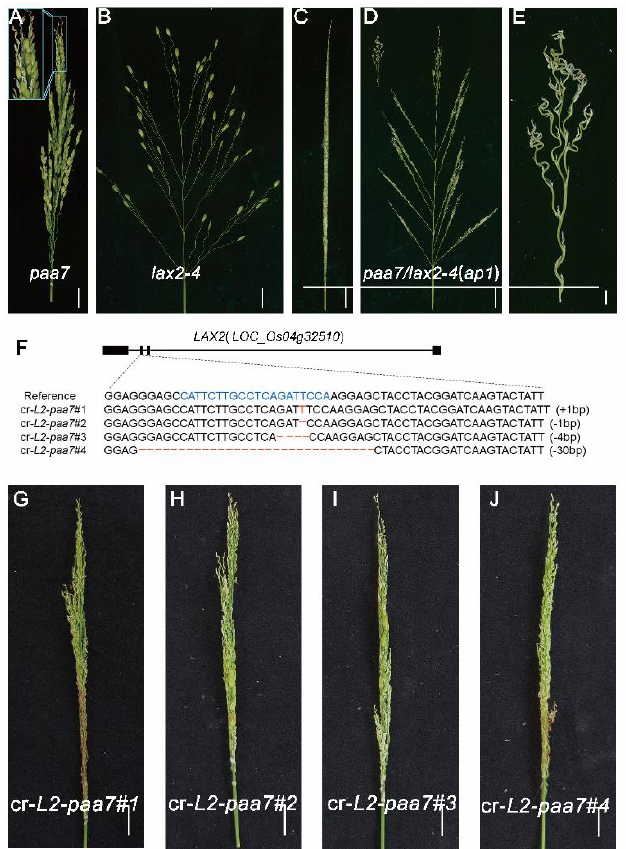
Figure 6. Phenotypic characterization of paa7/lax2 − 4 double mutants. Panicle of paa7 ( A ) , lax2-4 ( B ), paa7/lax2 − 4 ( C − E ), bars = 2 cm. ( F ) Sequencing results of targeted regions of in cr − L2 − paa7#1 − #4 tran − genic plants. Panicle of cr − L2 − paa7#1 ( G ), cr − L2 − paa7#2 ( H ) , cr − L2 − paa7#3 ( I ), and cr − L2 − paa7#4 ( J ), bars = 2 cm.